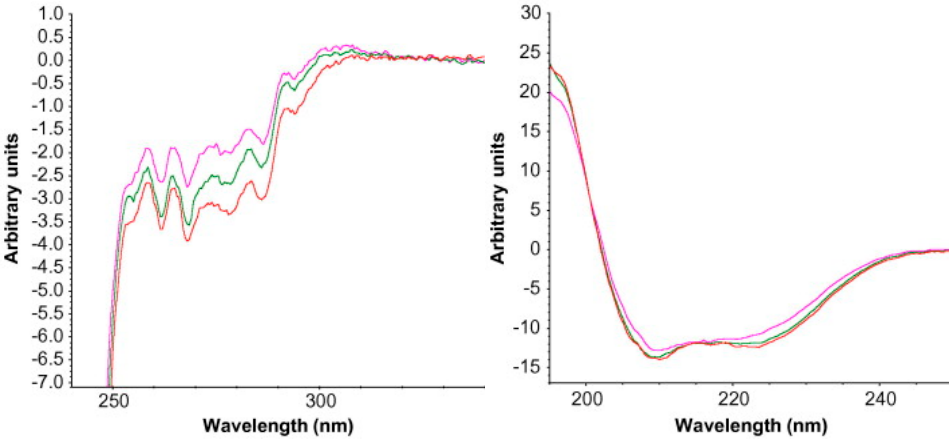
Figure 10. Circular dichroism (CD) spectra for reconstituted lyophilized protein incubated at two different temperatures. Changes in tertiary structure are seen in the near-UV CD spectra on the left, while changes in secondary structure are shown in the far-UV CD spectra on the right. Red spectra—lyophilized protein (control), green spectra—incubation at 37 °C, pink spectra—incubation at 60 °C. Reproduced with permission from [85], Elsevier, 2008.